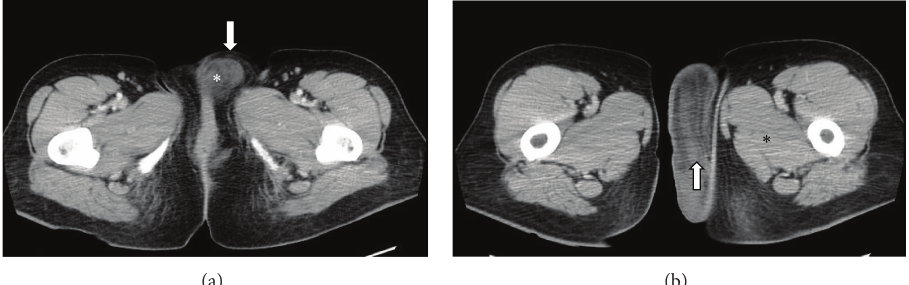
Figure 1: (a) Axial noncontrast CT image showing vulvar skin edema (arrow) and the suspected aggressive angiomyxoma at its anterior origin. (b) Axial CT image with contrast showing the posterior extent of the aggressive angiomyxoma with the swirled appearance (arrow) and the attenuation difference between it and surrounding skeletal muscles; less attenuation compared to skeletal muscle (asterisk).